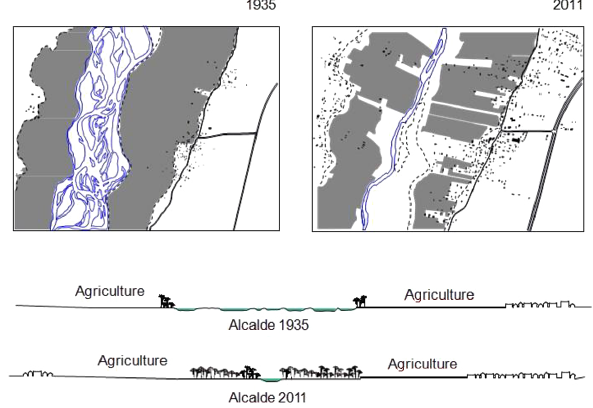
Figure 8. Changes in landscape morphology of the community of Alcalde (Earth Data Analysis Center, 2010; Rio Arriba County As- sessor’s Office,